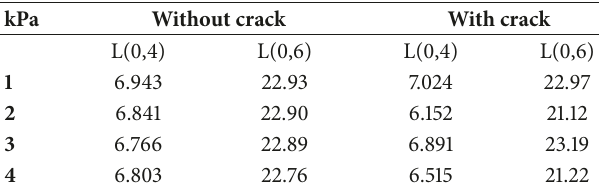
Table 4: Amplitudes of L(0,4) and L(0,6) without and with crack when the rotor rotates at